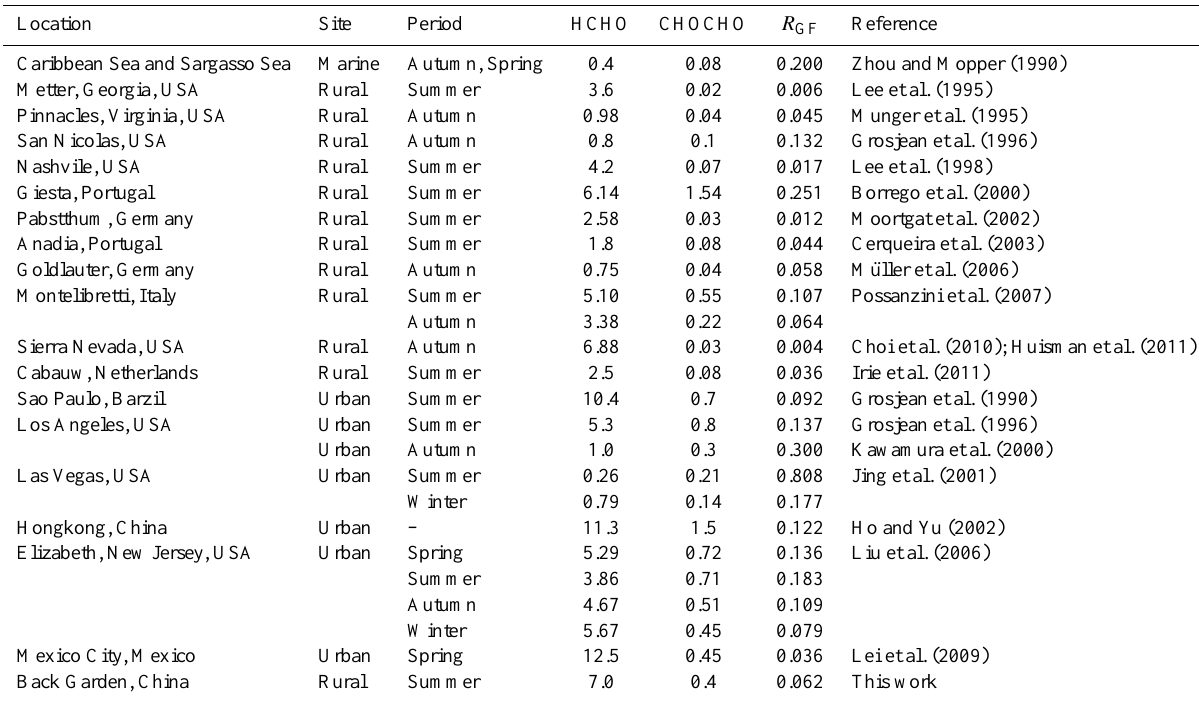
Fig. 9. Comparison of tropospheric NO 2 VCDs derived from MAX-DOAS and OMI observations during the PRIDE-PRD2006 campaign. The x-axis in (a) and (b) corresponds to the NO 2 VCDs derived from the geometric approach and the NO 2 vertical distribution retrieval, respectively. The dots represent data obtained on the 9 cloud-free days. The regression and correlation results for the dots and triangles are shown in red and grey texts, respectively. The regression lines are forced through the origin. Table 4. Overview of campaign average values of HCHO and CHOCHO mixing ratios (unit: ppb) and R GF in different environments in the world. Results shown here are in conditions that simultaneous HCHO and CHOCHO measurements are